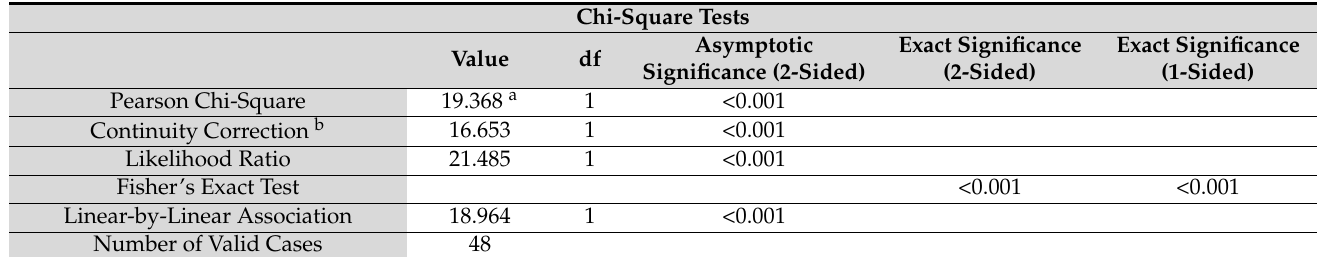
Table 1. Results of the chi-square test of independence showing that SC patients were significantly more likely than nSC patients to have neurologic symptoms other than chorea.